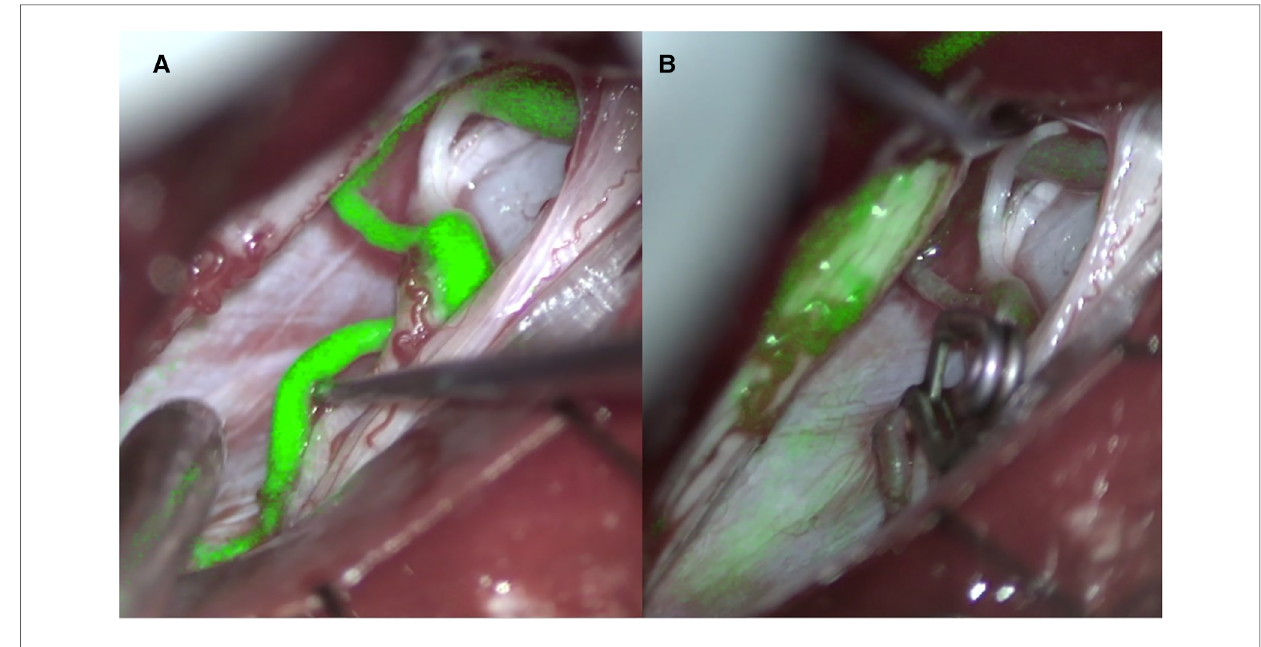
FIGURE 2 Indocyanine angiography pre ( A ) and post ( B ) clipping of the point of fi stula (right D12 dural arteriovenous fi